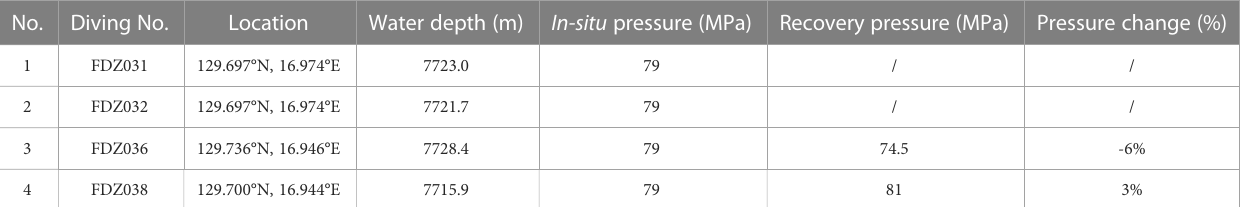
TABLE 2 Sea trial